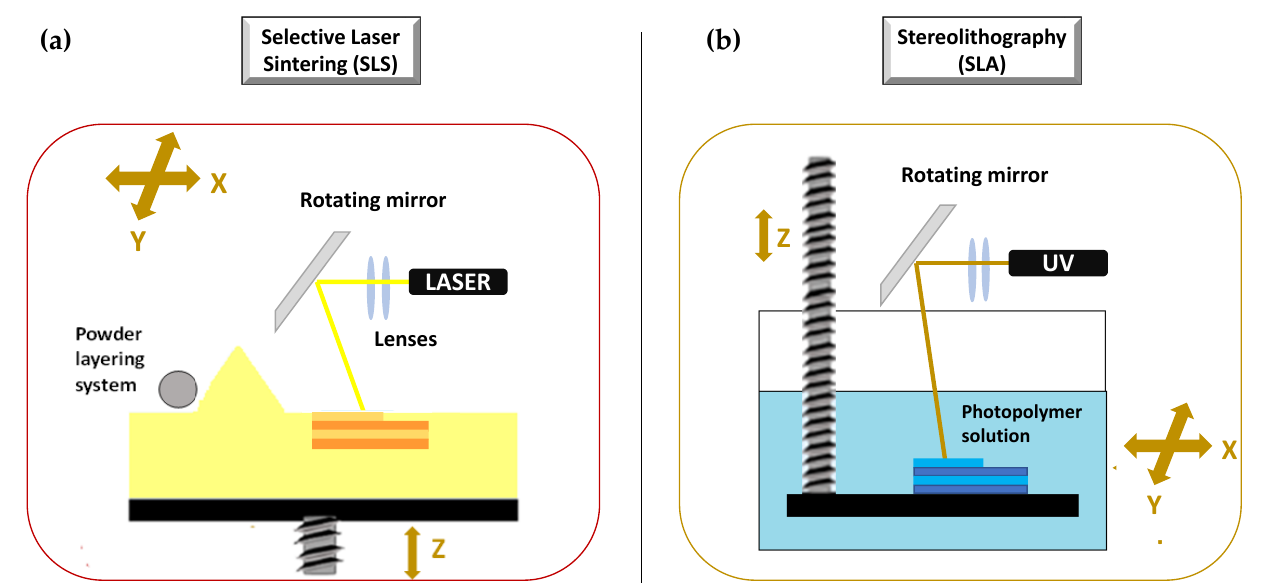
Figure 10. Illustration of SLS ( a ) and SLA ( b ) processes.